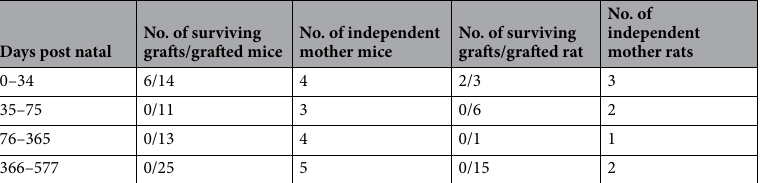
Table 1. Number of in utero transplanted animals with grafts containing healthy cells over all animals sacrificed during the post transplant time interval (days) indicated in the first column. For each time interval the third and fifth columns indicate the number of independent pregnant female mice or female rats mothers to the sacrificed transplanted animals of each species. Siblings coming from the same mother were sacrificed at different time points. Differences between graft survival according to animal age groups were highly statistically significant (mice: χ 2 , 23.211; degrees of freedom (DF) 3, p < 0.0001; rats χ 2 , 15.942; DF 3; p <